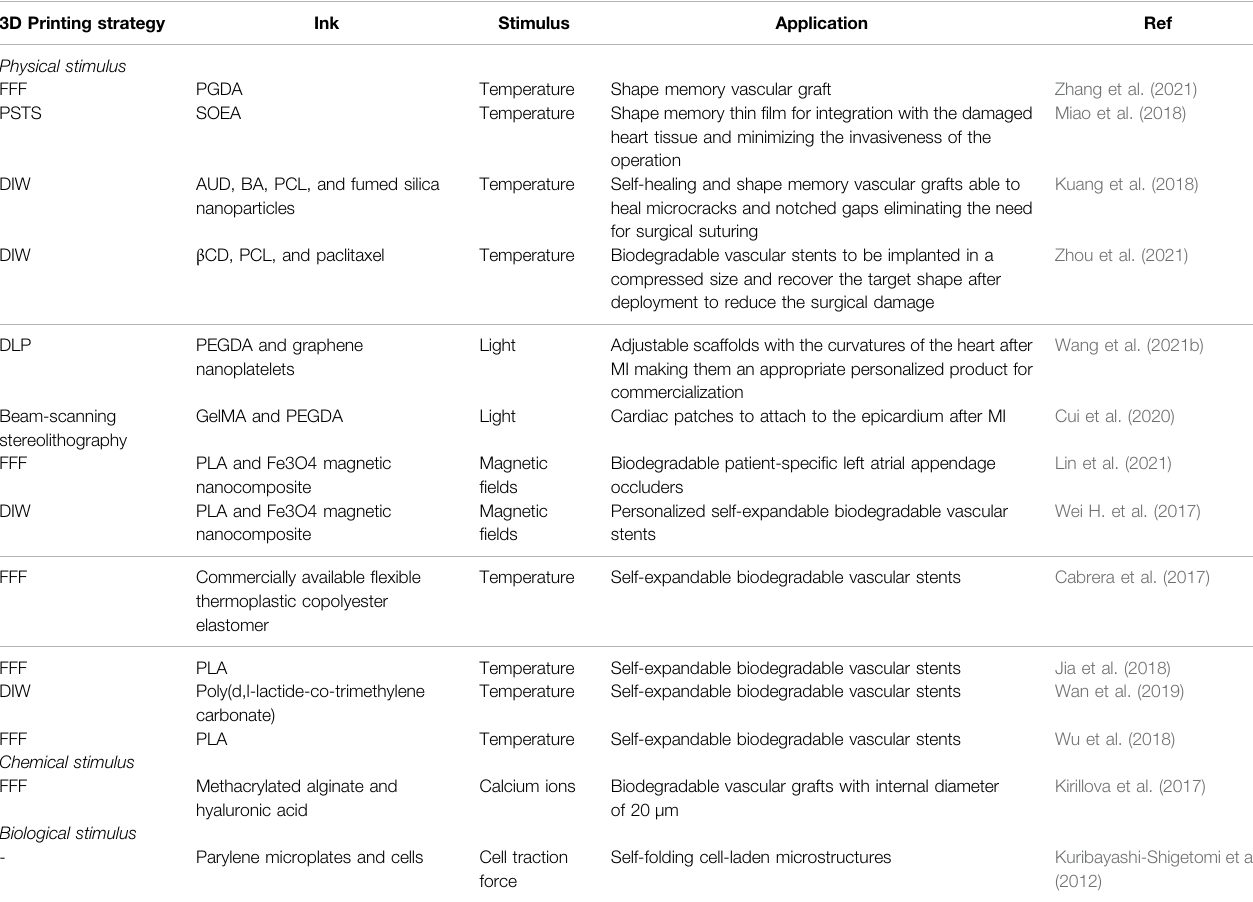
TABLE 1 | 4D printed cardiovascular implants classi fi ed according to the